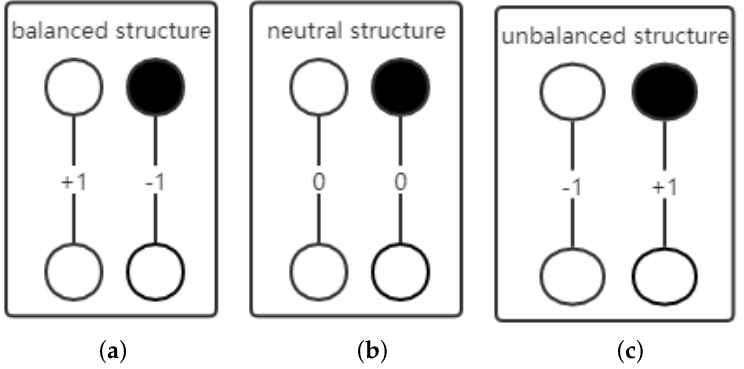
Figure 1. ( a ) Balanced binary groups, ( b ) neutral binary groups, ( c ) unbalanced binary groups.